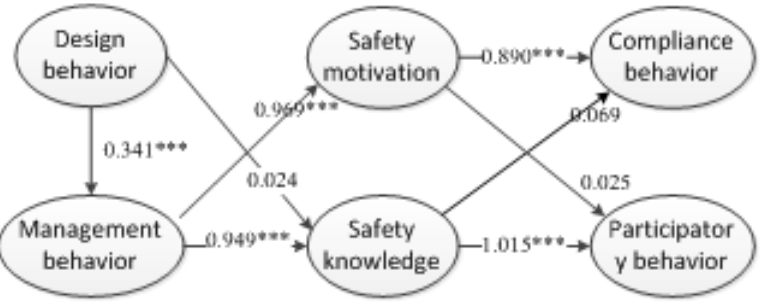
Figure 2. Research Variables and Measurement